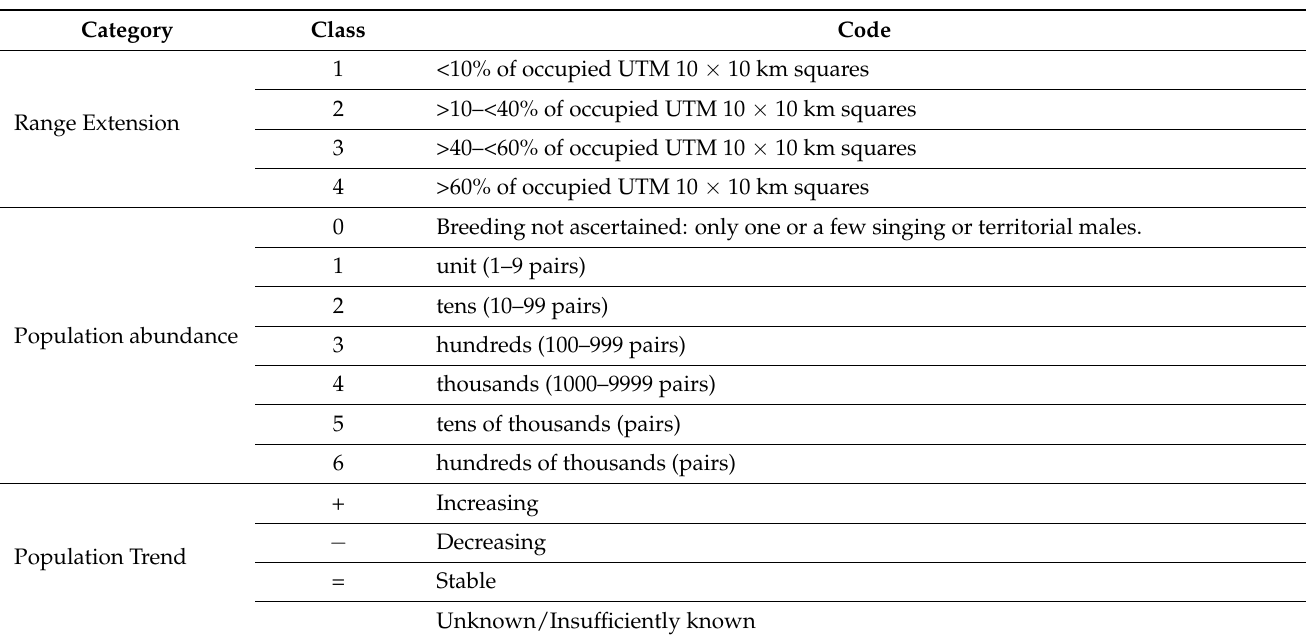
Table 3. Criteria, classes, and codes applied to define the Red List (conservation status) for each breeding taxon (See text for details).